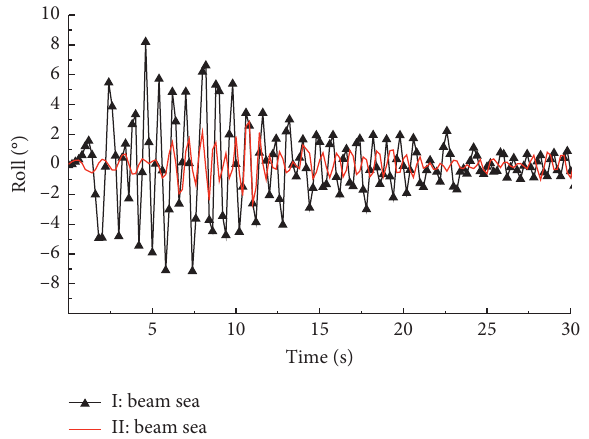
Figure 15: Time series of ship roll motion at different navigational positions without mooring